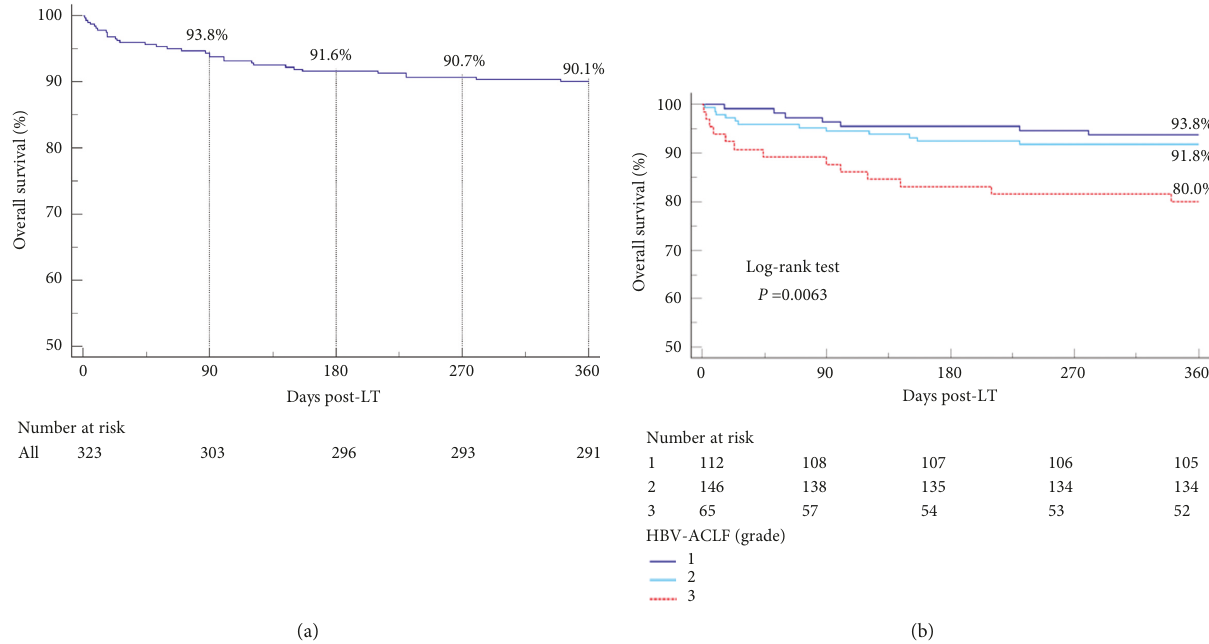
Figure 2: One-year overall survival of LT recipients who developed HBV-ACLF. One-year overall survival rates of (a) all recipients with HBV-ACLF and of (b) all recipients stratified by ACLF grade at LT.